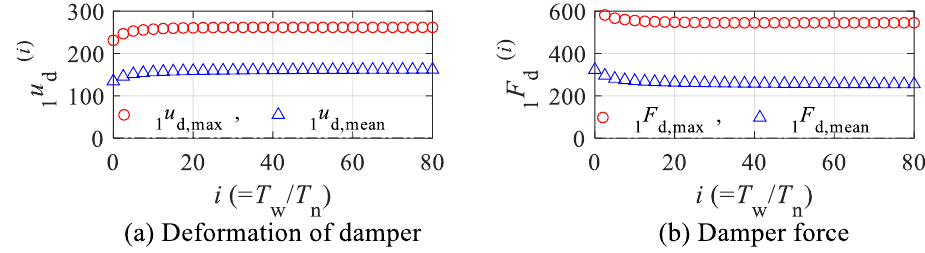
Figure A2. Analysis of damper energy dissipation